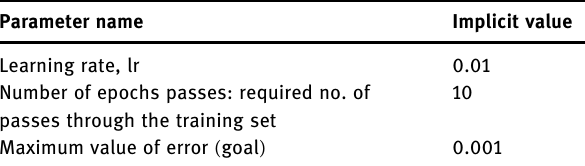
Table 2: Initiating the learning process by setting parameters